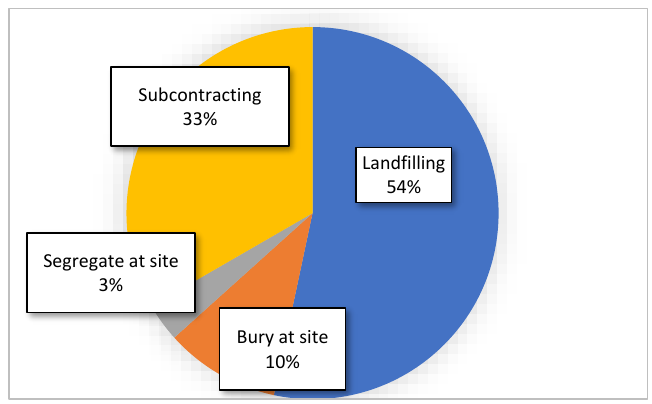
Figure 8. Methods of C&D waste disposal at the project sites.